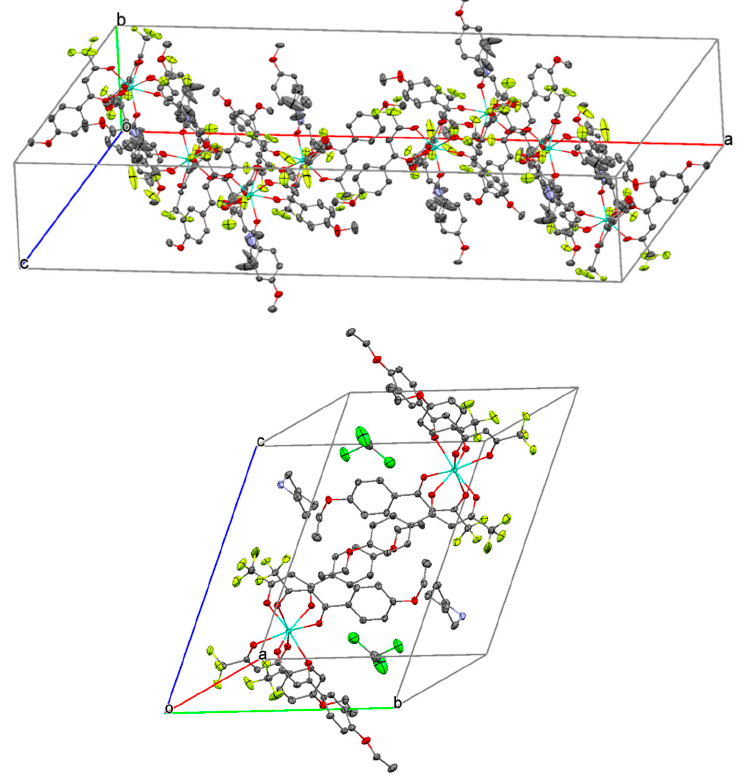
Figure 6. Crystal packing diagram of the complexes 2a ( above ) and 2b ( below ). Aqua blue, pale green, darkblue, red, and green ellipsoids show Eu, F, N, O, and Cl atoms, respectively. Table 1. Selected bond lengths (Å) and angles (°) for the complex 2a .